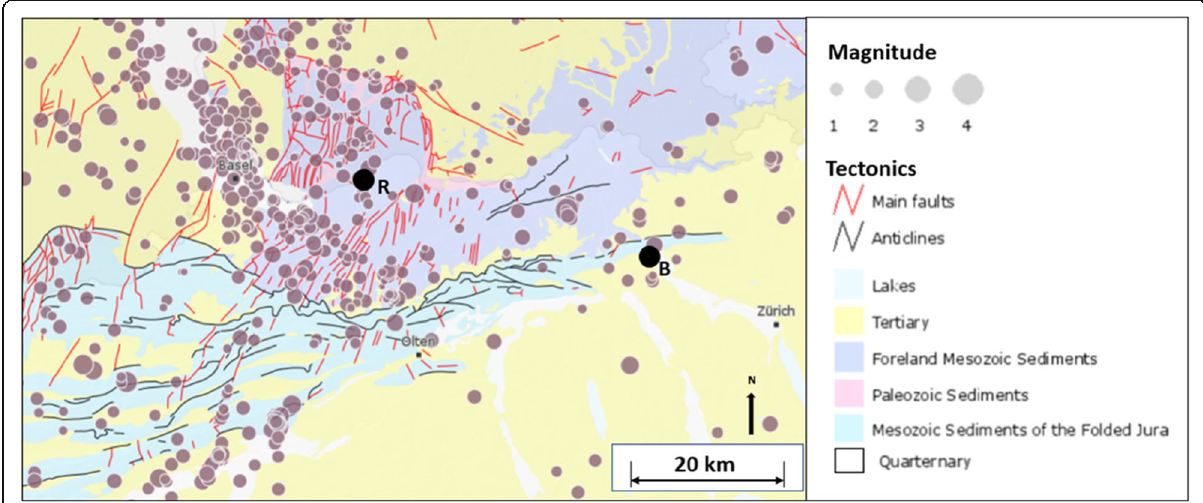
Fig. 3 Map of the area of Northern Switzerland and the bordering countries of France and Germany with represented magnitudes of the main occurring earthquakes. The two Fluorescence monitoring locations Rheinfelden (R) and Baden (B) are indicated with bold blackish dots. The reddish lines represent the main tectonic faults in the nearby area of the measurement locations. The greyish circles illustrate the locations of the registered earthquakes since 2001. The size of the circles corresponds to the magnitude of the earthquakes according to the legend on the right side of the figure (modified after SED)